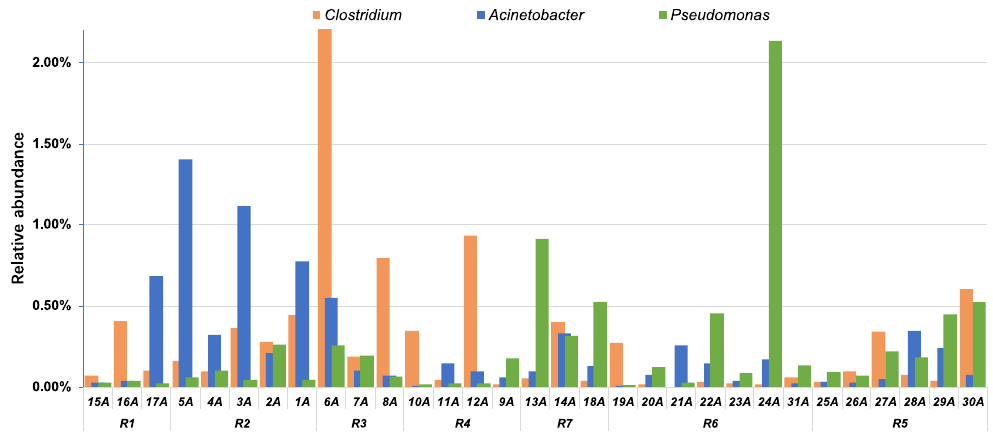
Figure 7. Distribution and composition of dominant fecal bacteria at the genus level.